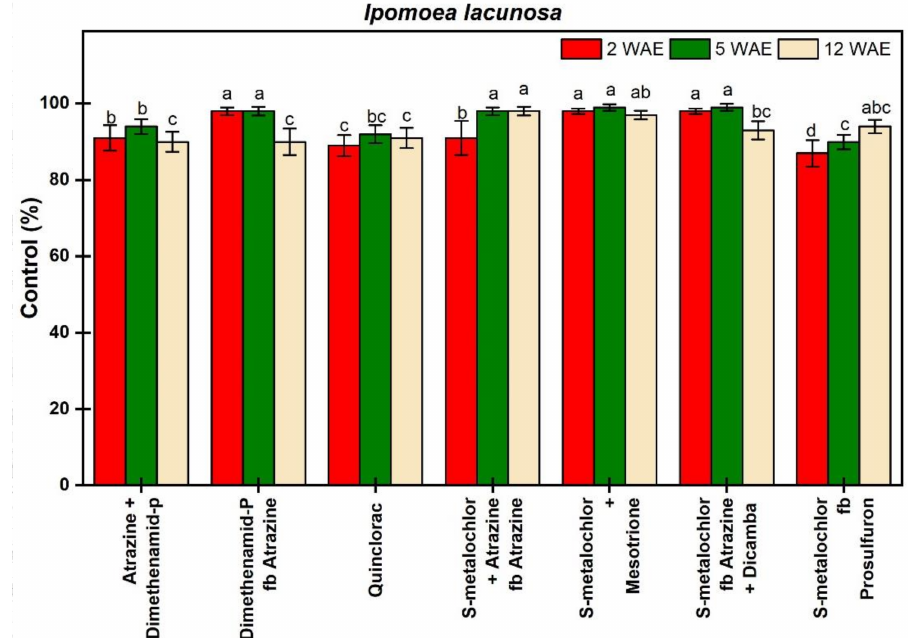
Figure 1. Ipomoea lacunosa control with di ff erent herbicide treatments at 2, 5, and 12 weeks after emergence (WAE). Data were analyzed separately for each WAE. Data were pooled over three years. The same letters on bars indicate no significant di ff erences at p < 0.05, according to Fisher’s least significant di ff erence test. The abbreviation “fb” means “followed